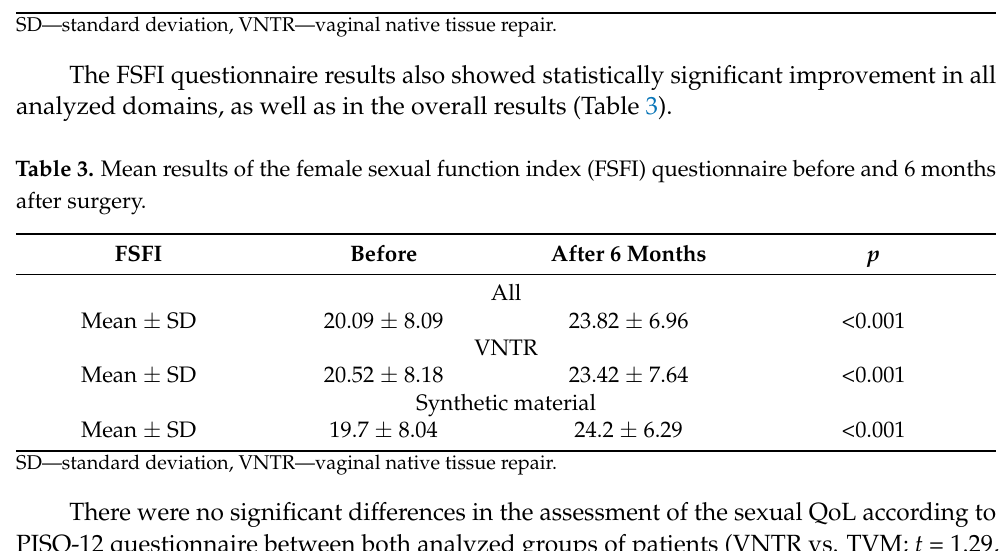
Table 2. Mean results of the pelvic organ prolapse or urinary incontinence sexual questionnaire (PISQ-12) scoring before and 6 months after both types of reconstructive surgery. PISQ-12 Before After 6 Months p All Mean ± SD 27.24 ± 7.85 32.43 ± 6.48 <0.001 VNTR Mean ± SD 27.40 ± 7.32 31.64 ± 6.71 <0.001 Synthetic material Mean ± SD 27.09 ± 8.37 33.16 ± 6.23 <0.001